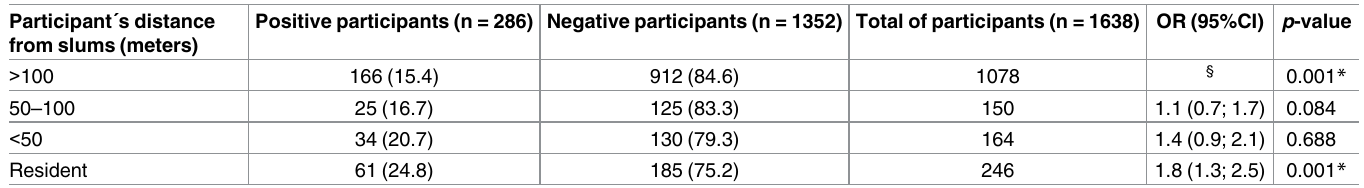
Table 9. Number of positive and negative participants to intestinal parasitesaccording to their distance over the slums in Rio de Janeiro municipality. Participant´s distance from slums